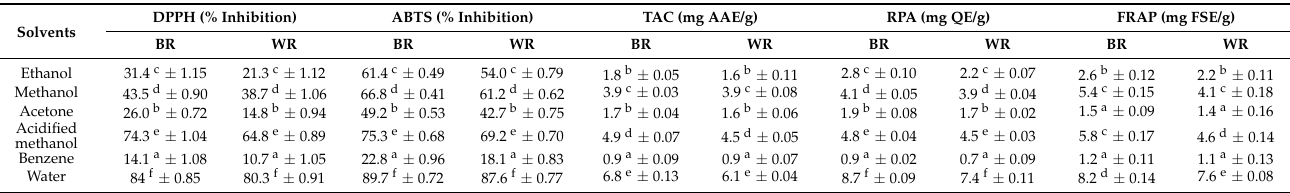
Table 4. Antioxidant properties shown by rye extracts during different